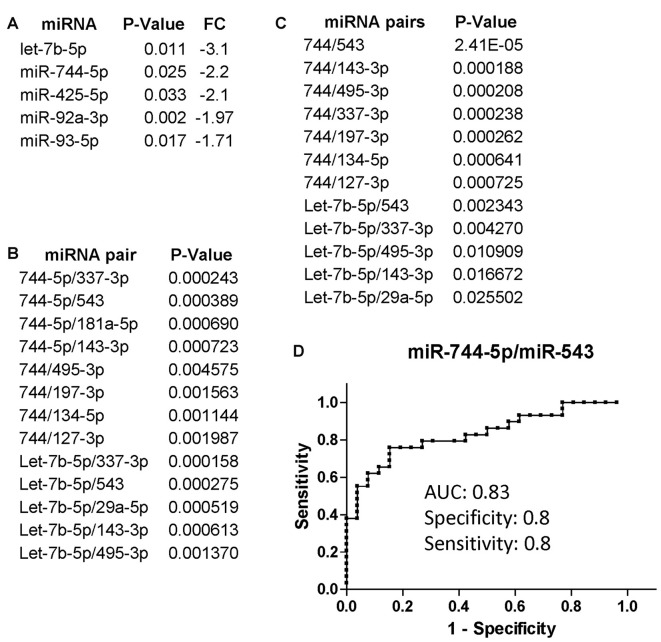
miRNA and miRNA pairs that discriminated cognitively impaired (CI) PLWHA from non-impaired at LSUHSC. List of differentially regulated miRNAs (A) and miRNA pairs (B) in CI vs. non-impaired patients. FC, fold change. Note that downregulated miRNAs (fold change < 0.5) are represented as the negative value of the reciprocal. (C) miRNA pairs that better discriminated CI (n = 29) from non-impaired (n = 25) subjects, after removing subjects with severe AUD (AUDIT score ≥ 18). (D) ROC analysis of the miRNA pair miR-744-5p/miR-543. AUC, area under the curve.